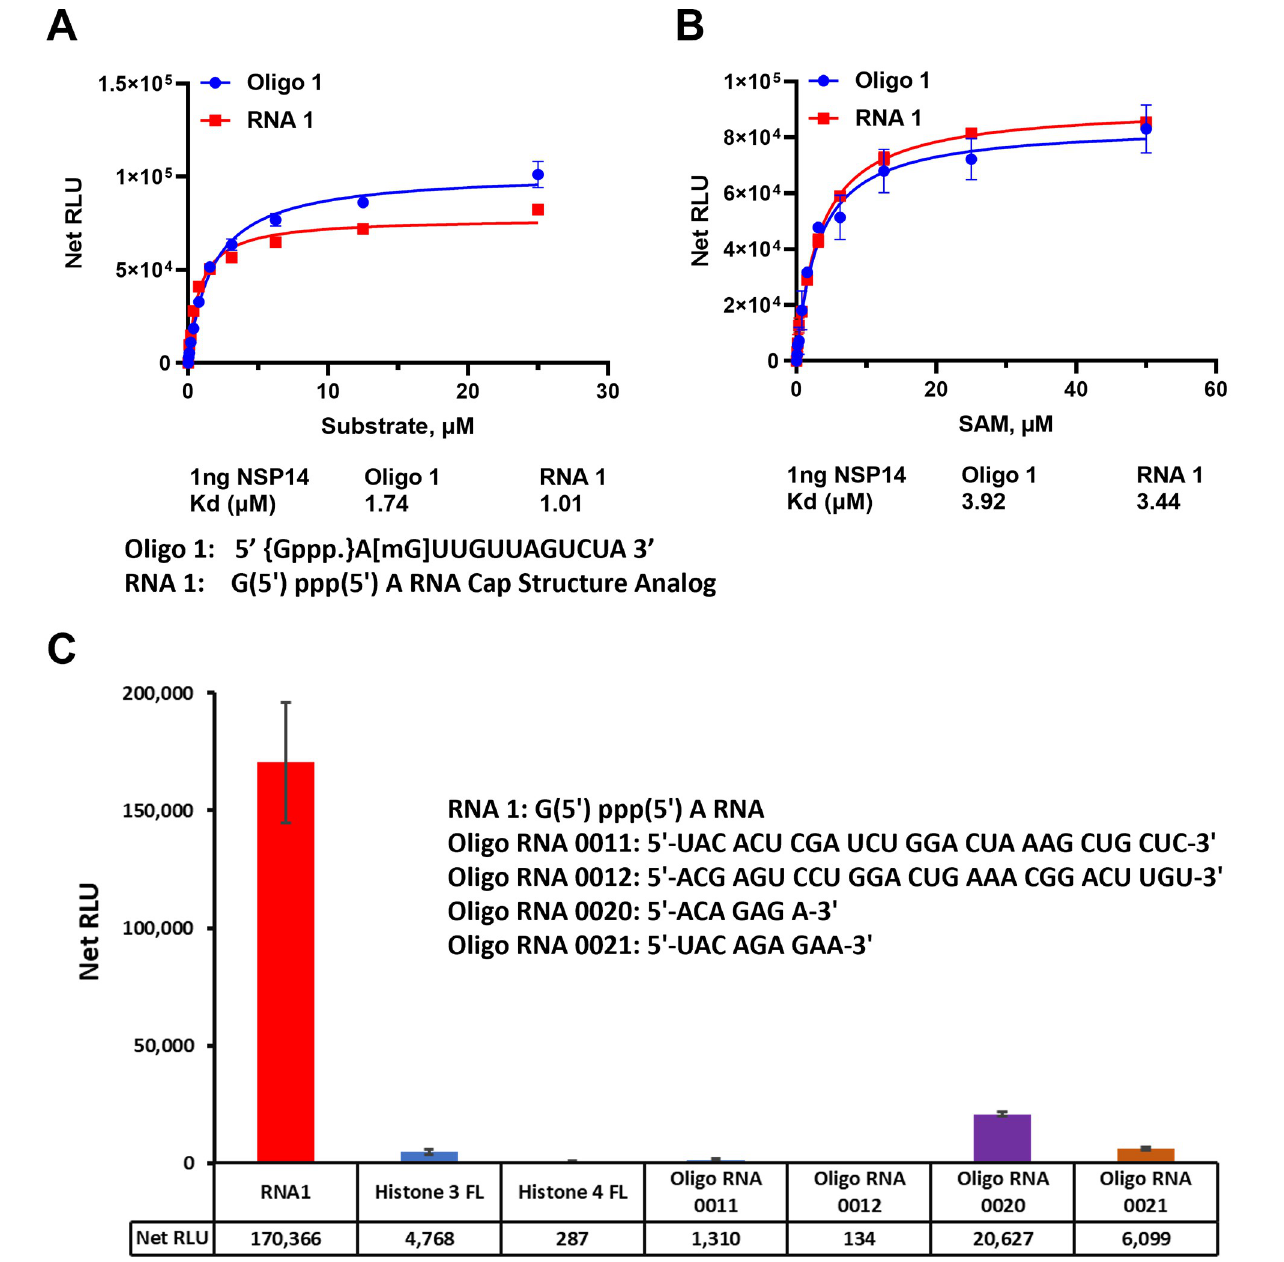
Fig 3. SARS-CoV-2 nsp14 MTase kinetic parameters and substrate specificity. (A) SARS-CoV-2 nsp14 enzyme activity was monitored using a titration of uncapped (RNA1) short sequence and uncapped oligo 1 but methylated at the penultimate nucleotide sugar in the presence of 50 μ M SAM per reaction. (B) Titration of SAM substrate using saturating concentrations of RNA substrates, 25 μ M of oligo 1 and 50 μ M of RNA1. The data were generated using 1ng of nsp14 per reaction at 23˚C for 30min. (C) Substrate selectivity of nsp14 using different RNA sequences and proteins known to be methylated. Reactions were carried out using 1ng of nsp14 per reaction with 50 μ M SAM and 25 μ M of each Oligo RNA and 20 μ M for both Histones and reactions were carried out at 37˚C for 80min in white solid 384LV-well plate. MTase-Glo ™ Assay was performed as described in Materials and Methods section. Each point represents an average of two data points; the error bars represent the standard deviation. Data analysis was performed with GraphPad Prism 1 software, version 9.1.0, for Windows 1 using a One Site Binding (hyperbola) program (panel A and B) and with Microsoft 1 Excel 365 program (panel C). All substrate sequences are shown in their specific